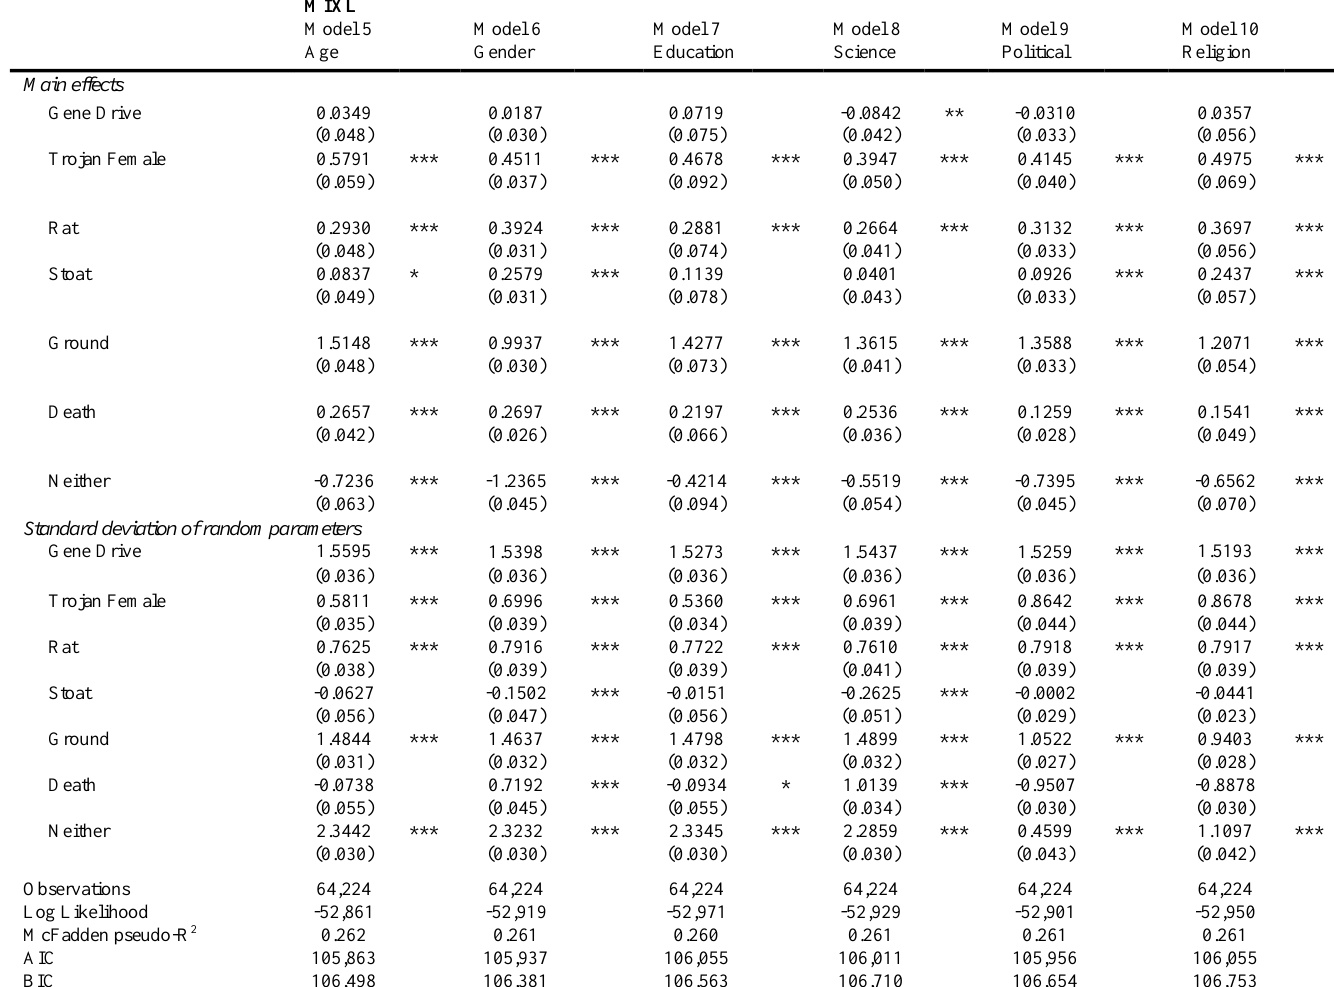
APPENDIX 3: Model results with demographic and psychometric variables. Coefficients are log odds ratios with standard errors